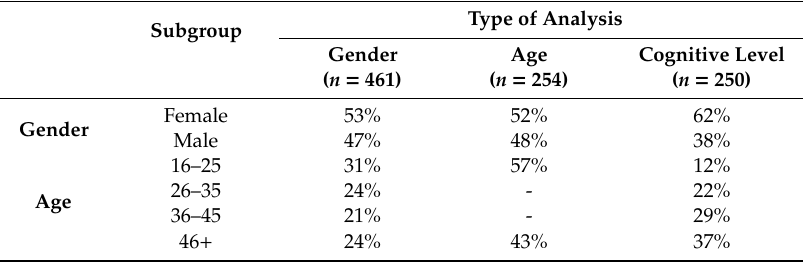
Table 1. Demographic of participants by gender, age, and cognitive